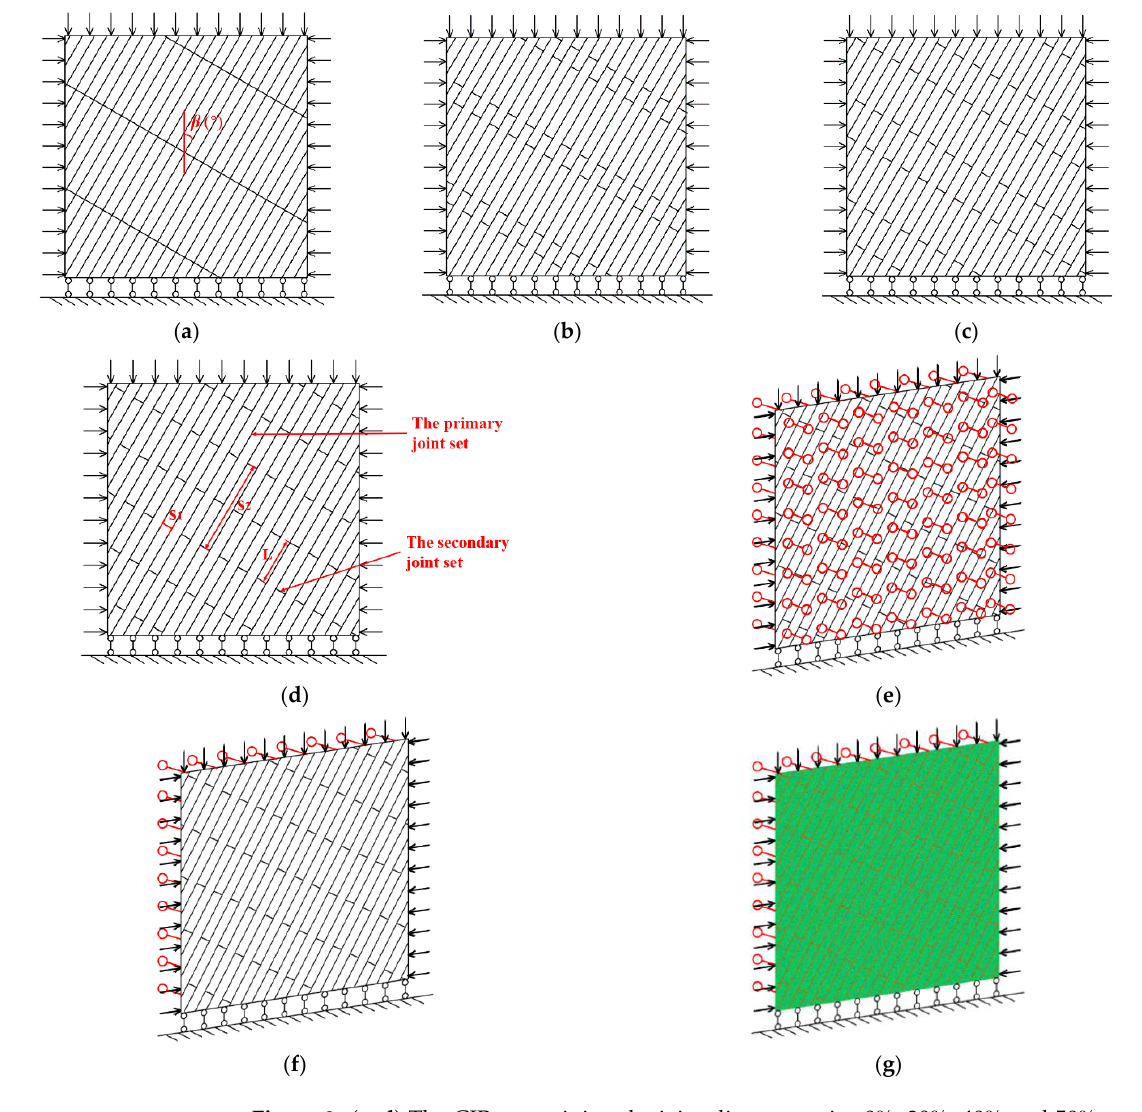
Figure 3. ( a – d ) The CJBs containing the joint distance ratios 0%, 20%, 40% and 50%, respectively; ( e ) the model setup under plane strain; ( f , g ) the model setup for the case between plane stress and plane strain.